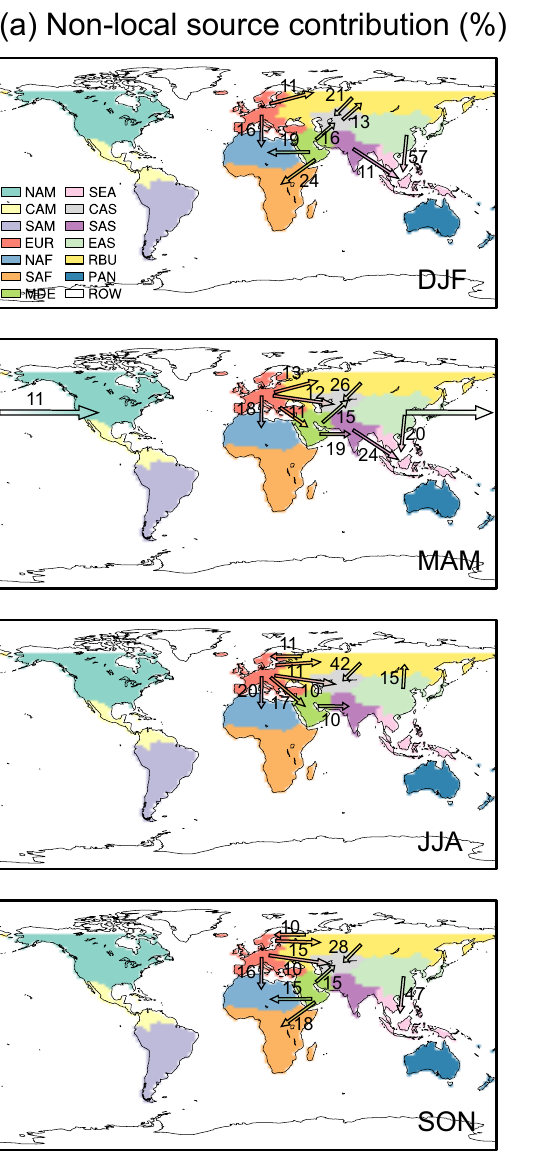
Figure 4. Relative contributions of non-local sources to seasonal near-surface sulfate concentrations (left panels) and wind fields over 850hPa (right panels). Arrows with numbers show contributions (%) of a source region to sulfate over a receptor region. Only relative concentrations larger than 10% are